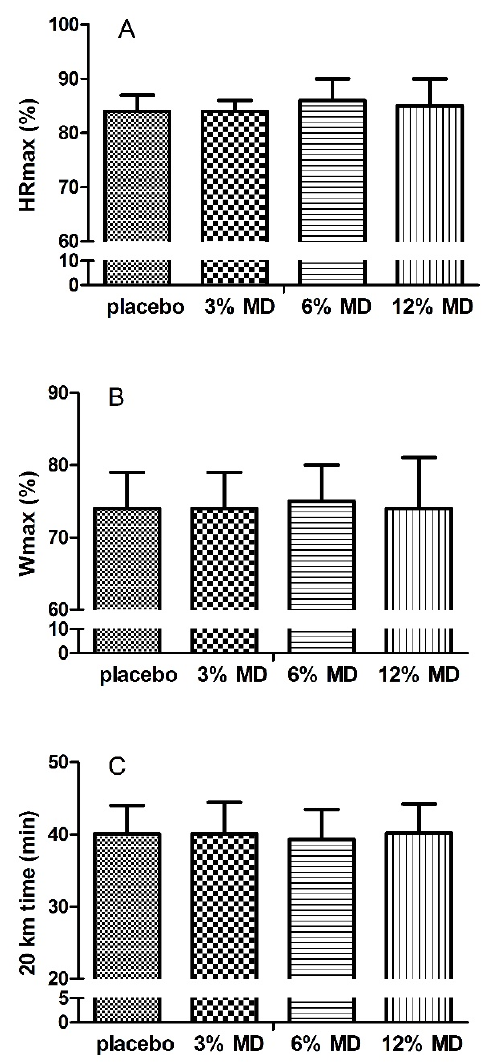
Figure 2. Percentages of HR max ( A ); W max ( B ), achieved and 20 km time trial times ( C ). MD, maltodextrin. HR max , maximum heart rate. W max , maximum cycling power. No significant interaction effect for trial x time for blood lactate, glucose and heart rate ( F( 1.99, 7.96) = 0.465, F( 2.9, 23.3) = 1.191 and F( 2.92, 20.51) = 0.67, respectively, p > 0.05) (Figure 3) or main effect of trial ( F( 3, 12) = 0.931, F( 3, 24) = 1.072 and F( 3, 21) = 0.768, respectively, p > 0.05) was detected indicating that these physiological responses to the 20 km time trial were similar among the MD rinsing trials and placebo. However, a significant main effect for time was observed for lactate, glucose and heart rate ( F( 1.08, 4.32) = 13.31, F( 1.6, 12.8) = 10.48 and F( 1.36, 9.54) = 111.743, respectively, p < 0.05) indicating that all these variables increased during each trial (Figure 3). Bonferroni post hoc analysis showed that heart rate increased significantly every 5 km distance ( p < 0.05, Figure 3). Glucose levels at 10–15 km and 15–20 km distance periods were significantly higher than at 0–5 km ( p < 0.05, Figure 3). Lactate levels at 5–10 km and 10–15 km distance periods were significantly higher compared to 0–5 km distance period ( p < 0.05, Figure 3).